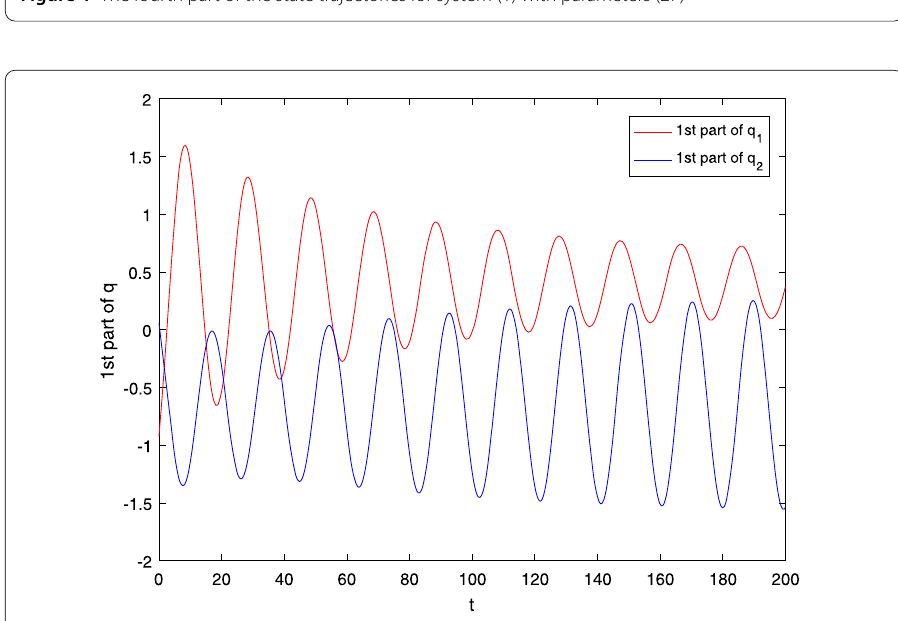
Figure 5 The first part of the state trajectories for system (1) with δ =